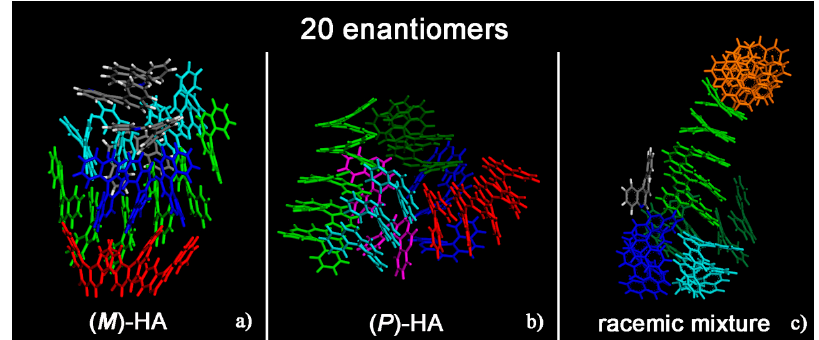
Figure 1. Optimized geometries at the end of the molecular dynamics (MD) run lasting 20 ns considering twenty (M)-HA molecules ( a ), twenty ( P )-HA molecules ( b ) and the racemic mixture of twenty enantiomers ( c ). The helicenes having π – π interaction with slightly parallel aromatic rings are colored with the same color.